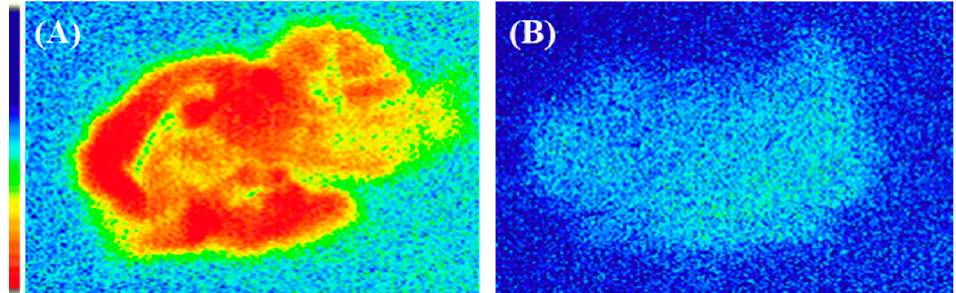
Figure 6. Ex vivo brain autoradiograms of [ 18 F]flumazenil only ( A ) and [ 18 F]flumazenil combined with 200 µ g diazepam (BZR agonist) ( B ), after post-injecting, via the tail vein, [ 18 F]flumazenil 37 MBq/0.2 mL for 30 min. (A) represents the binding of [ 18 F]flumazenil to the high-density cortical regions of the brain, while (B) represents that the binding of [ 18 F]flumazenil was blocked by the addition of diazepam.